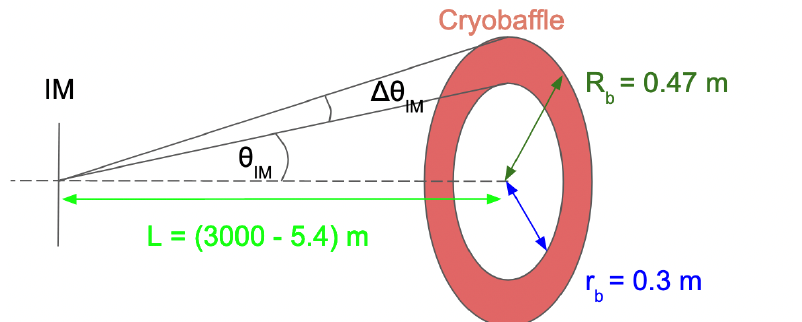
Figure 2. Solid angle into the direction of the IM. The cryobaffle is placed at about 3000 − 5.4 m from the IM. The value of the solid angle is δ Ω IM ms = 3.57 × 10 − 8